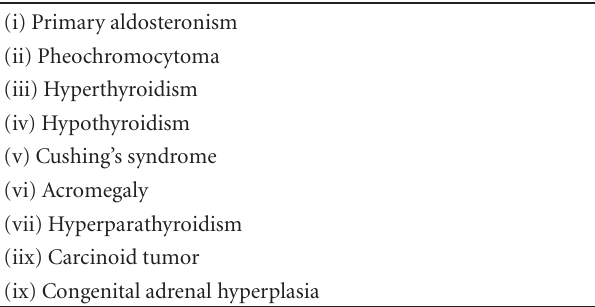
Table 3: Endocrine causes of secondary